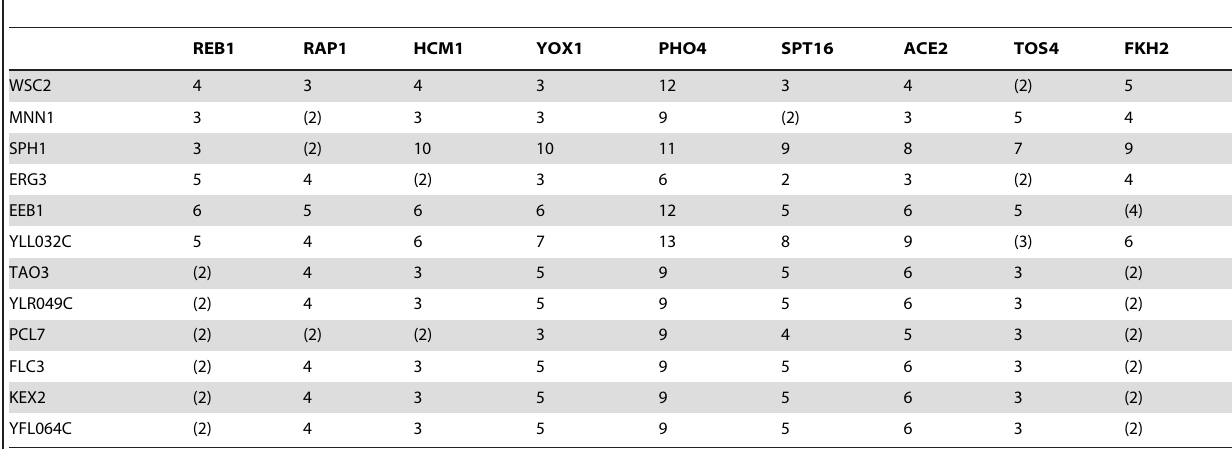
Table 1. Length of the shortest paths from all nine periodic genes in the SCC (first row) to periodic genes in G = SCC connected via at least one non periodic gene (first